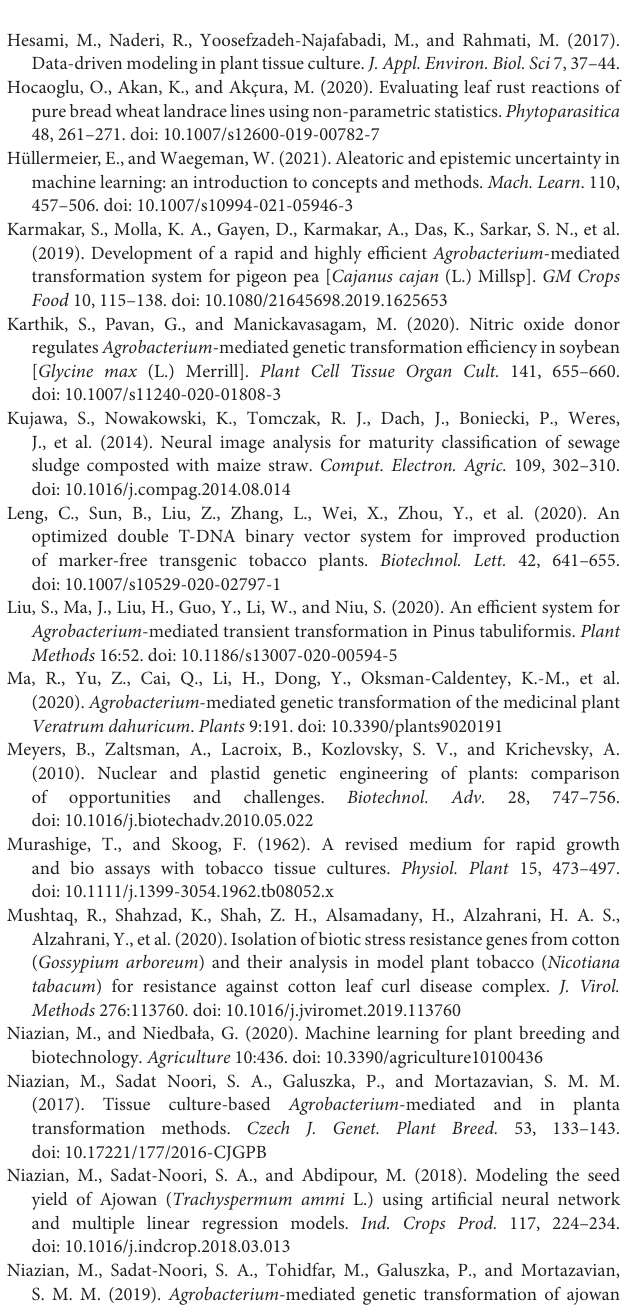
Supplementary Table 2 | The measured and the predicted values of the percentage of PCR-verified transgenic tobacco plants under the interaction effects of different levels of inputs. Supplementary Table 3 | The measured and the predicted values of the percentage of putative transgenic ajowan plants under the interaction effects of different levels of inputs.